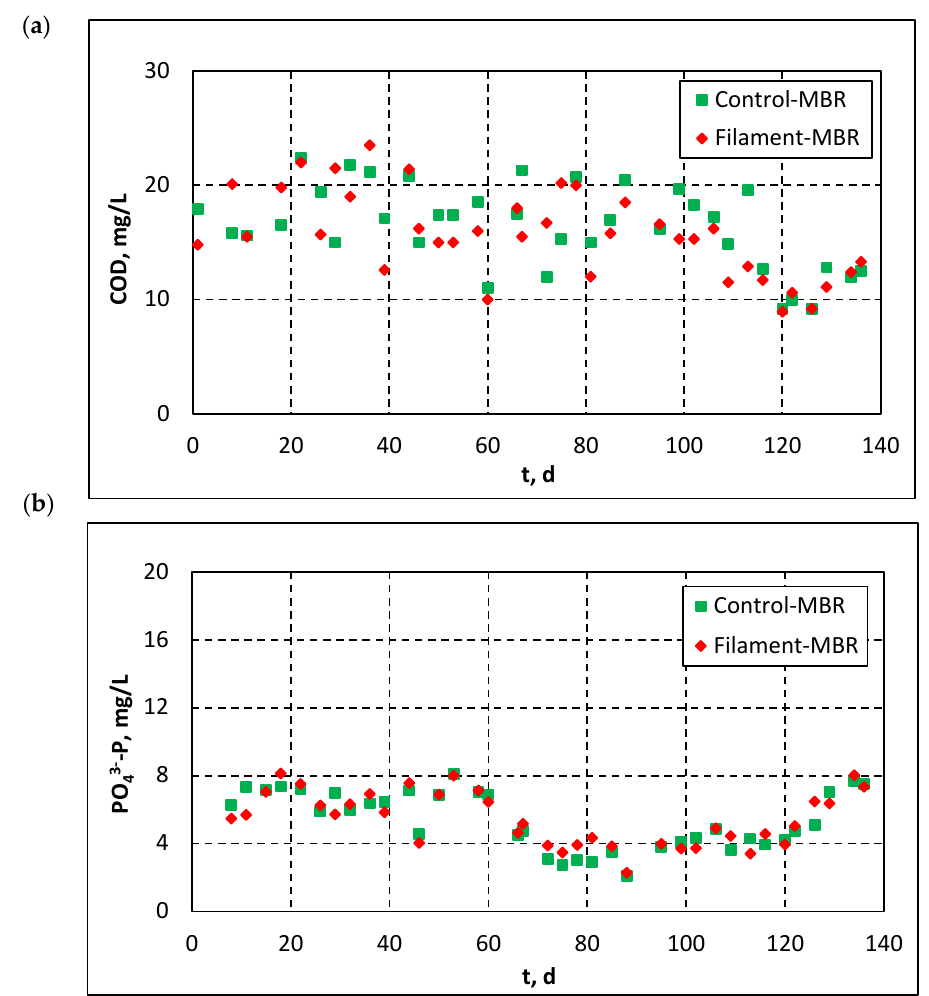
Figure 7. Evolution of concentrations of: ( a ) COD and ( b ) P-PO 43 − in the effluent of both pilot MBRs.